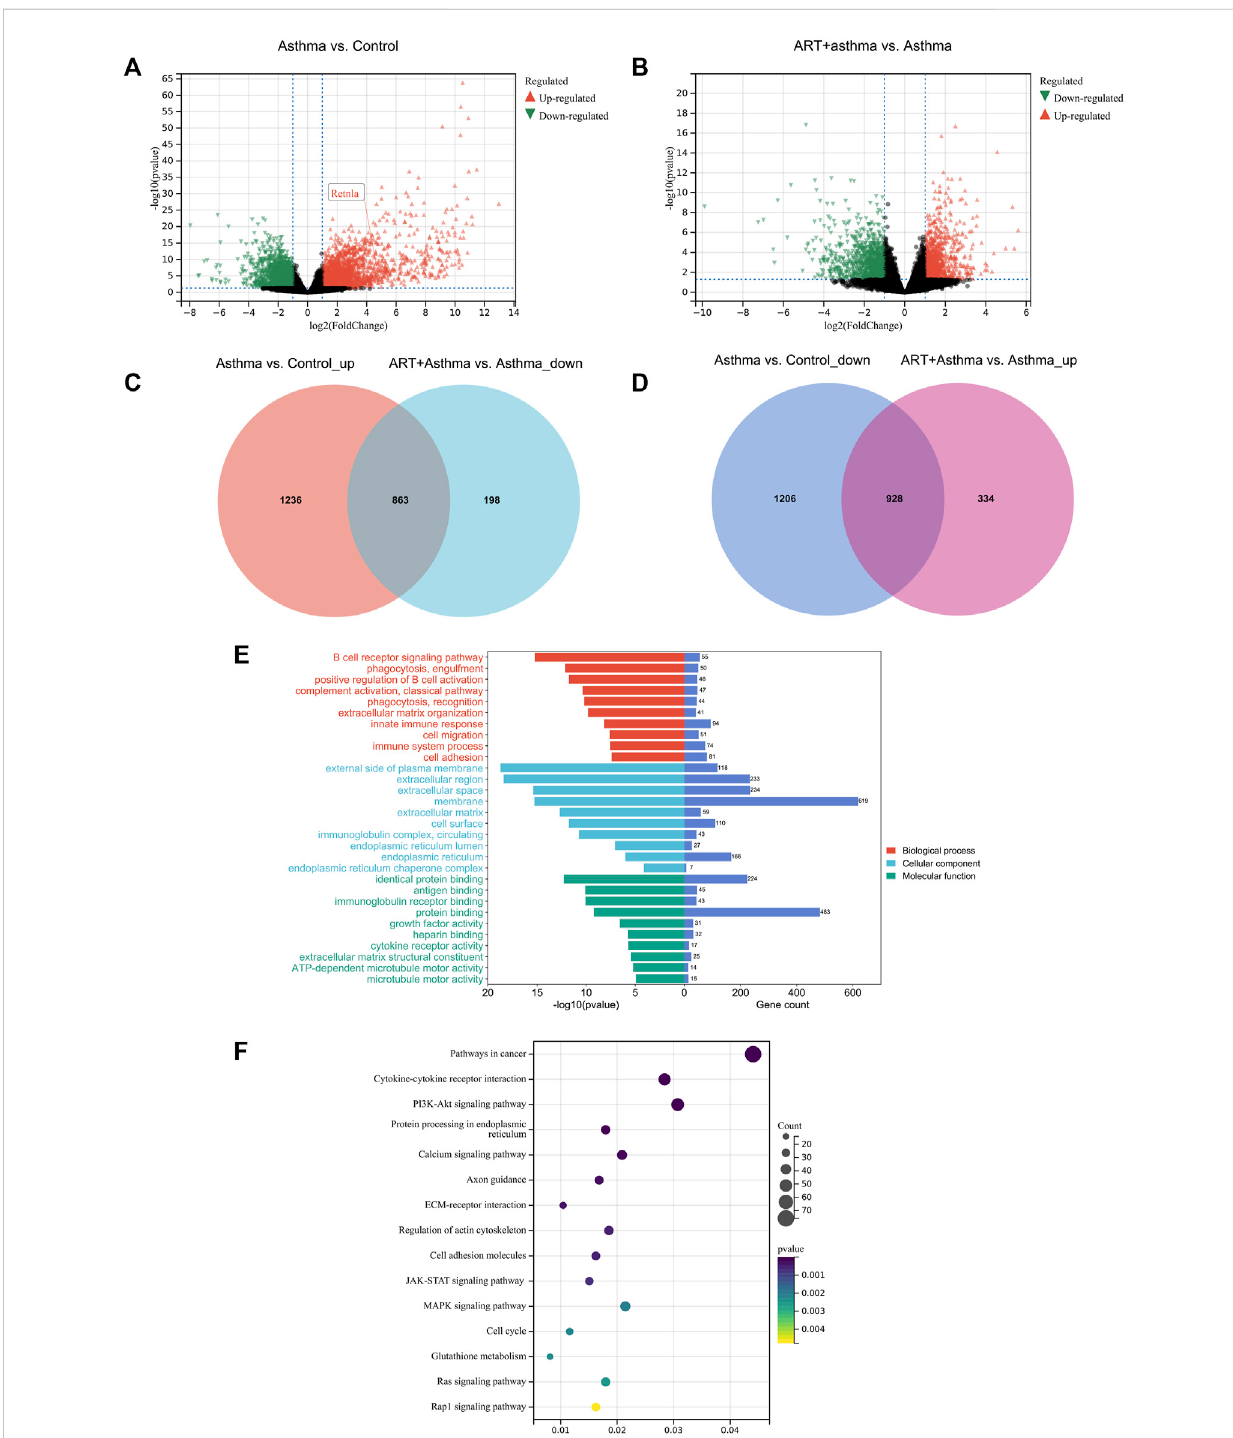
FIGURE 5 Transcriptionalanalysis ofARTagainstAsthmabyRNA-seqtechnology. (A,B) Volcanoplotofdifferentiallyexpressedgenes(DEGs)betweenAsthma vs.Control,andART+asthmavs.AsthmabasedonRNA-seqresults. (C,D) VenndiagramofupregulatedanddownregulatedDEGs. (E,F) GOandpathway enrichment analysis of the DEGs between ART + asthma and Asthma